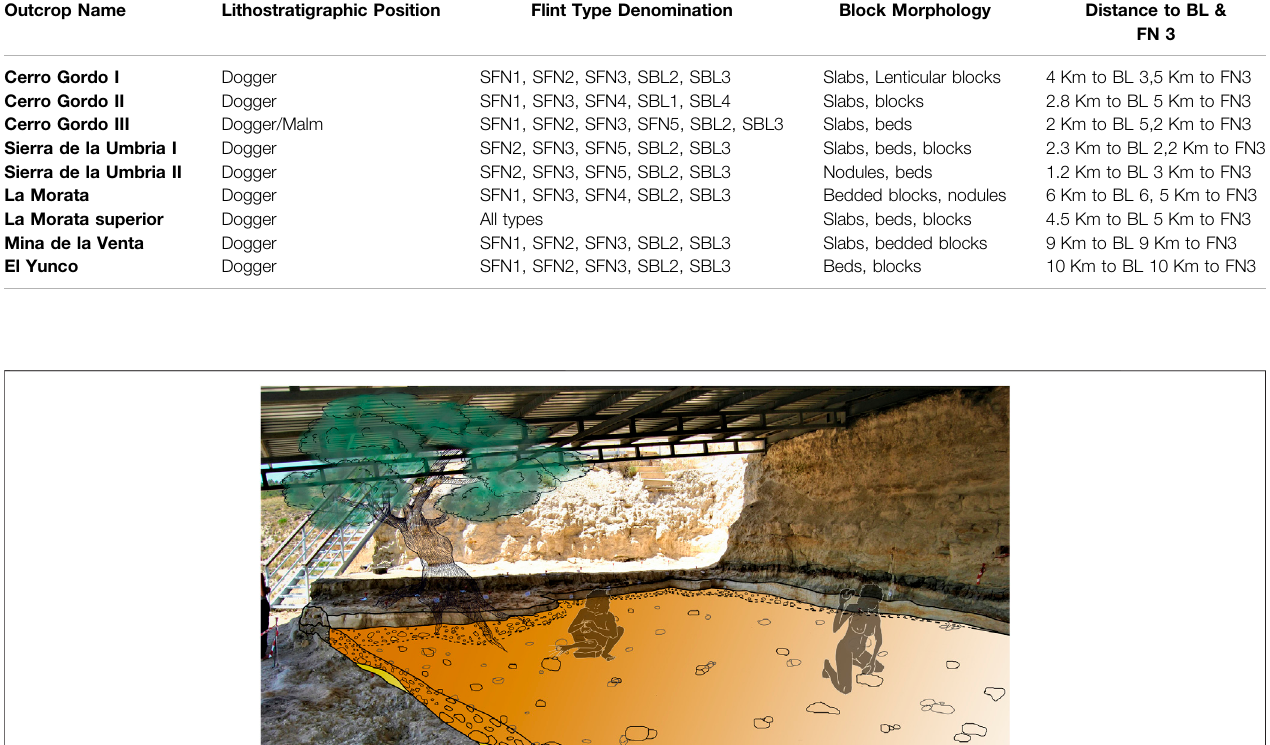
Frontiers in Earth Science |